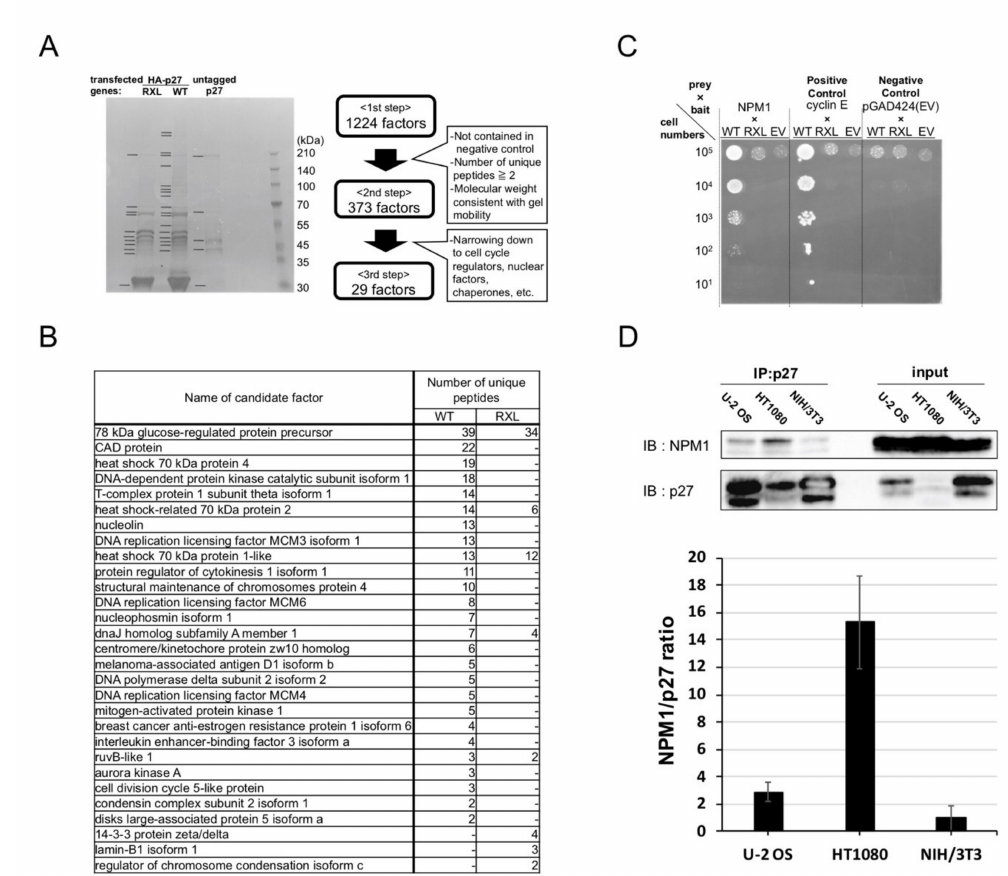
Figure 2. Screening for p27-interacting factors. ( A ) (left) CBB-stained SDS-PAGE gel image of anti-HA-immunoprecipitated lysates of the HEK293 cells transfected with HA-p27 wild type (WT, middle), HA-p27 RXL mutant (RXL, left), or untagged p27 (right). Protein extracts, from the bands marked with black bars, were subjected to mass spectrometry (MS). (right) Screening process for the candidate factors interacting with p27; ( B ) List of 29 candidate factors for interacting with p27 WT or RXL after the screening. Number of unique peptides identified in each of the MS samples is shown in the right columns; ( C ), Yeast two-hybrid assay between p27 and its interacting factors. PJ69-4A cells carrying the combinations of vectors expressing bait proteins (WT, p27 wild type; RXL, p27 RXL mutant; and EV, empty vector) and prey proteins (NPM1, nucleophosmin isoform 1; cyclin E; pGAD424, empty vector) were spotted onto the selection plate with five-step dilutions; ( D ) U-2 OS, HT1080 and NIH / 3T3 cells carrying Dox-inducible p27 were treated with 10 µ g / mL Dox for 24 h before harvest. The cell lysates were subjected to anti-p27 immunoprecipitation and Western blot analysis. Ratios of NPM1 protein amount co-immunoprecipitated with p27 protein are plotted in the right (relative to that in NIH / 3T3